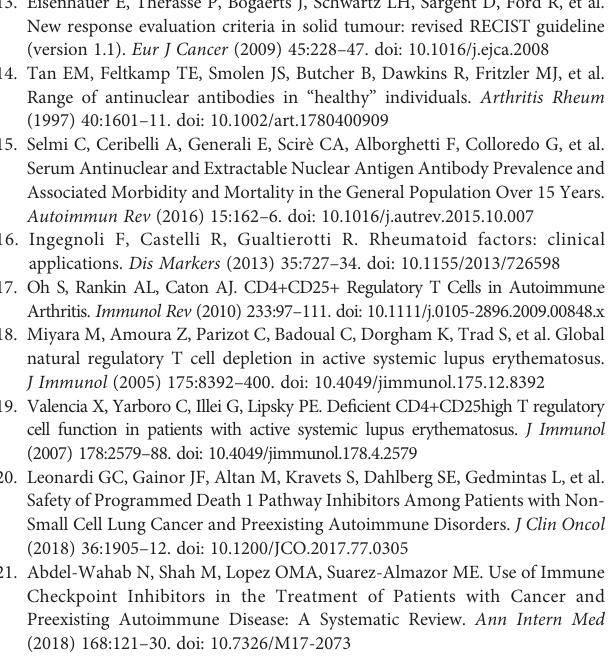
Supplementary Figure 2 | Kaplan-Meier survival curves of PFS and OS in the positive and negative ANA cohorts with a positive ANA cutoff of 1:80. (A) PFS in patients with non-adenocarcinoma tumors, (B) OS in patients with non- adenocarcinoma tumors, (C) PFS in patients with adenocarcinoma, (D) OS in patients with adenocarcinoma PFS, progression-free survival; OS, overall survival; ANA, anti-nuclear antibody. Supplementary Figure 3 | Kaplan-Meier survival curves of PFS and OS in the positive and negative RF cohorts when a positive RF cutoff of 15 was used. Survival analysis with ICI treatment: no signi fi cant difference in the PFS and OS was observed between the RF-positiveand RF-negativepatients. PFS,progression-free survival; OS, overall survival; RF, rheumatoid factor. Supplementary Figure 4 | Kaplan-Meier survival curves of PFS and OS in both positive ANA ( ≧ 1:40) and RF ( ≧ 15) or not. Survival analysis with ICI treatment: no signi fi cant difference in the PFS and OS was observed between both ANA and RF- positive and negative patients. PFS, progression-free survival; OS, overall survival; ANA, anti-nuclear antibody; RF, rheumatoid